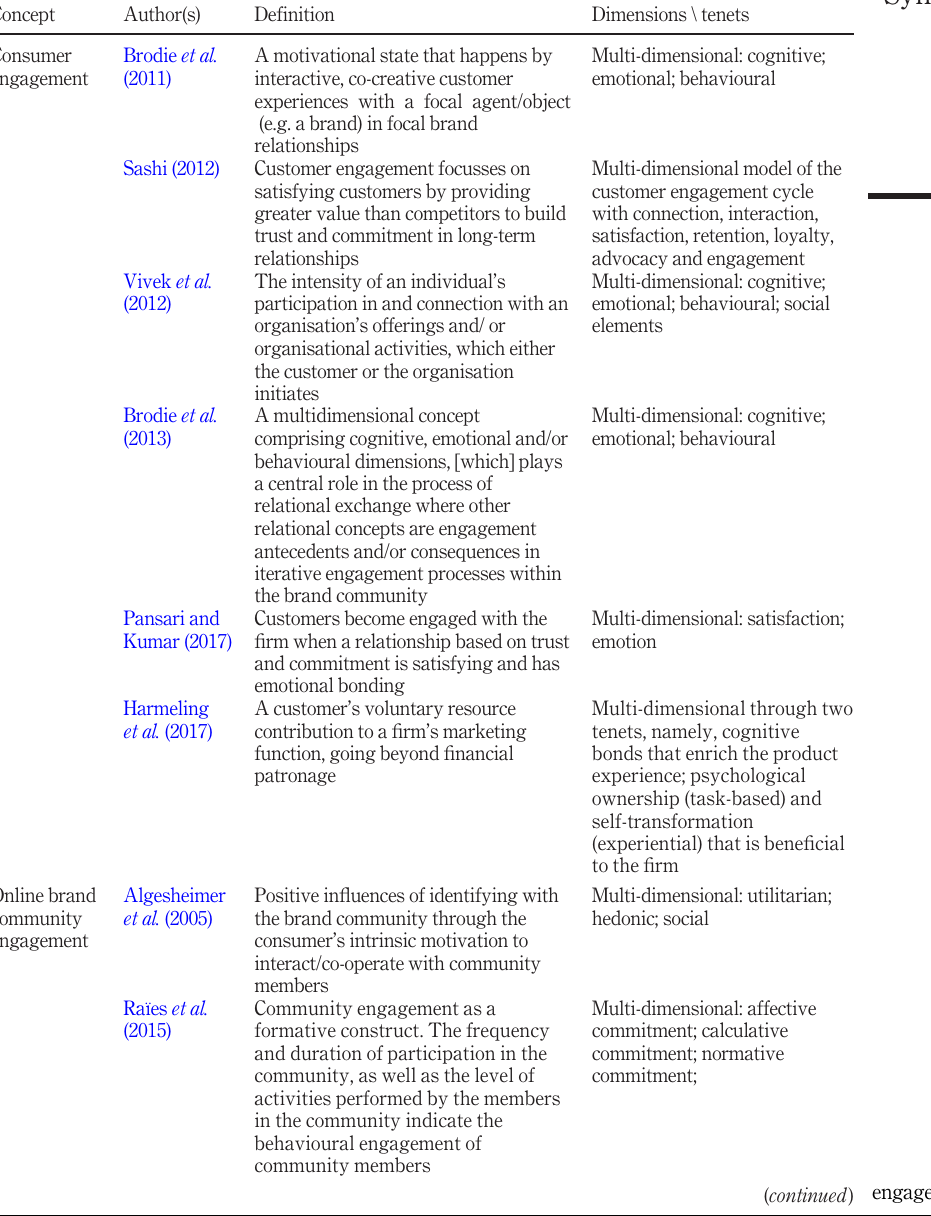
Table 3. Overview